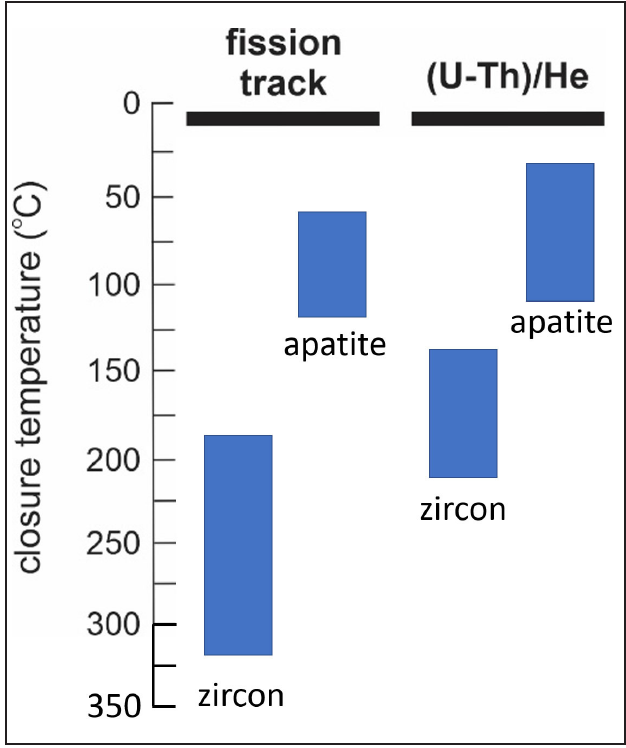
FIGURE 1 . Closure temperature for fission-track and (U-Th)/He methods applied in apatite and zircon (modified from Ault et al.